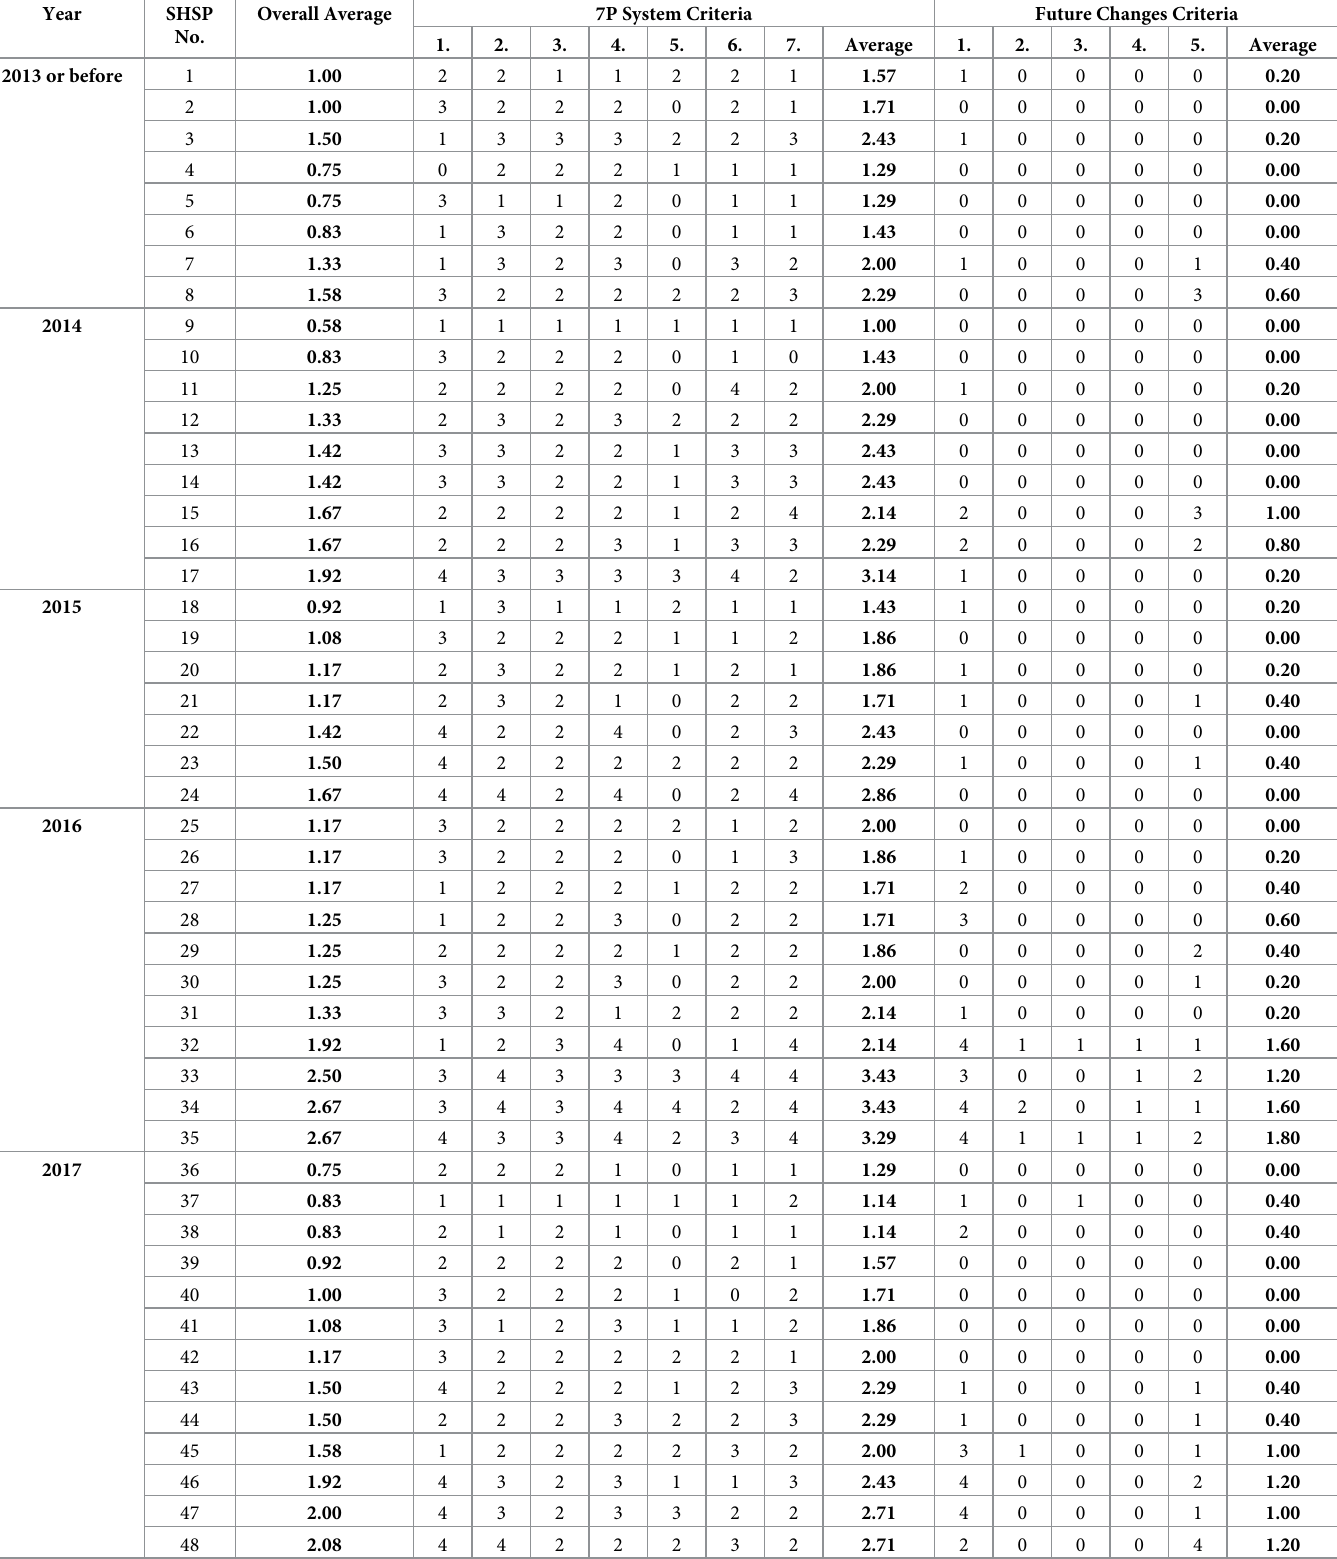
Table 6. Summary of individual SHSP assessment scores.